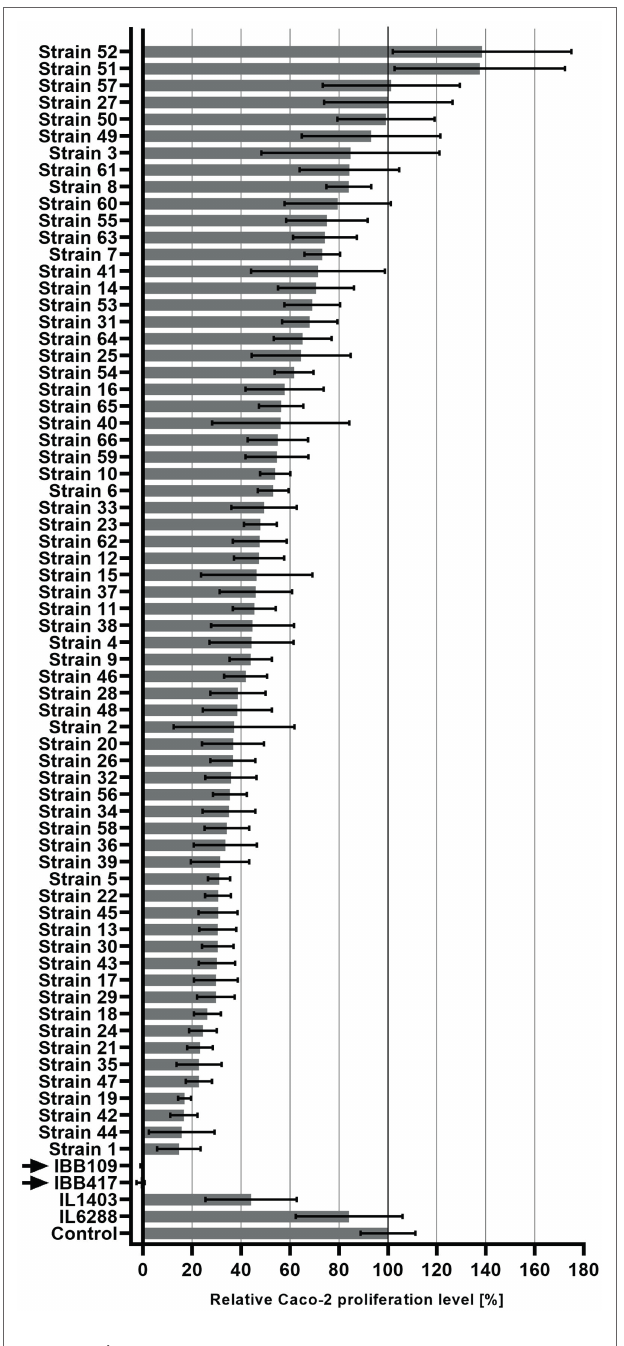
FIGURE 1 | Inhibitory effect of Lactococcus lactis strains on Caco-2 cell proliferation. Proliferation of Caco-2 cells incubated with L. lactis strains was measured in reference to bacteria-free Caco-2 cell culture (100%) using the BrdU colorimetric